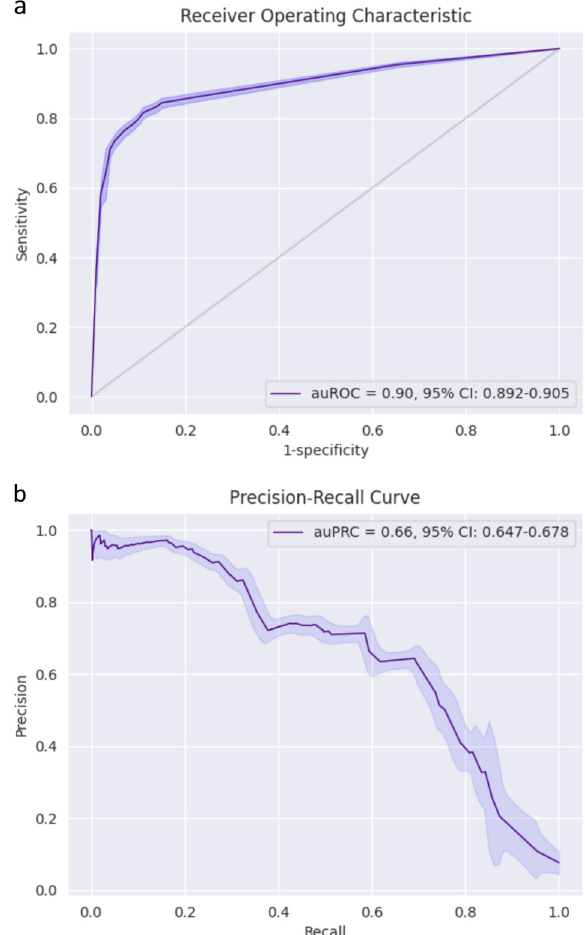
Fig. 1 Model performance. a ROC curves of the predictive model on the prospective test set. The light band around the curve represents pointwise 95% con fi dence intervals derived by boot- strapping. b A plot of the precision (positive predictive value, PPV) against the recall (sensitivity) of the predictor for different thresh- olds. The light band around the curve represents pointwise 95% con fi dence intervals derived by